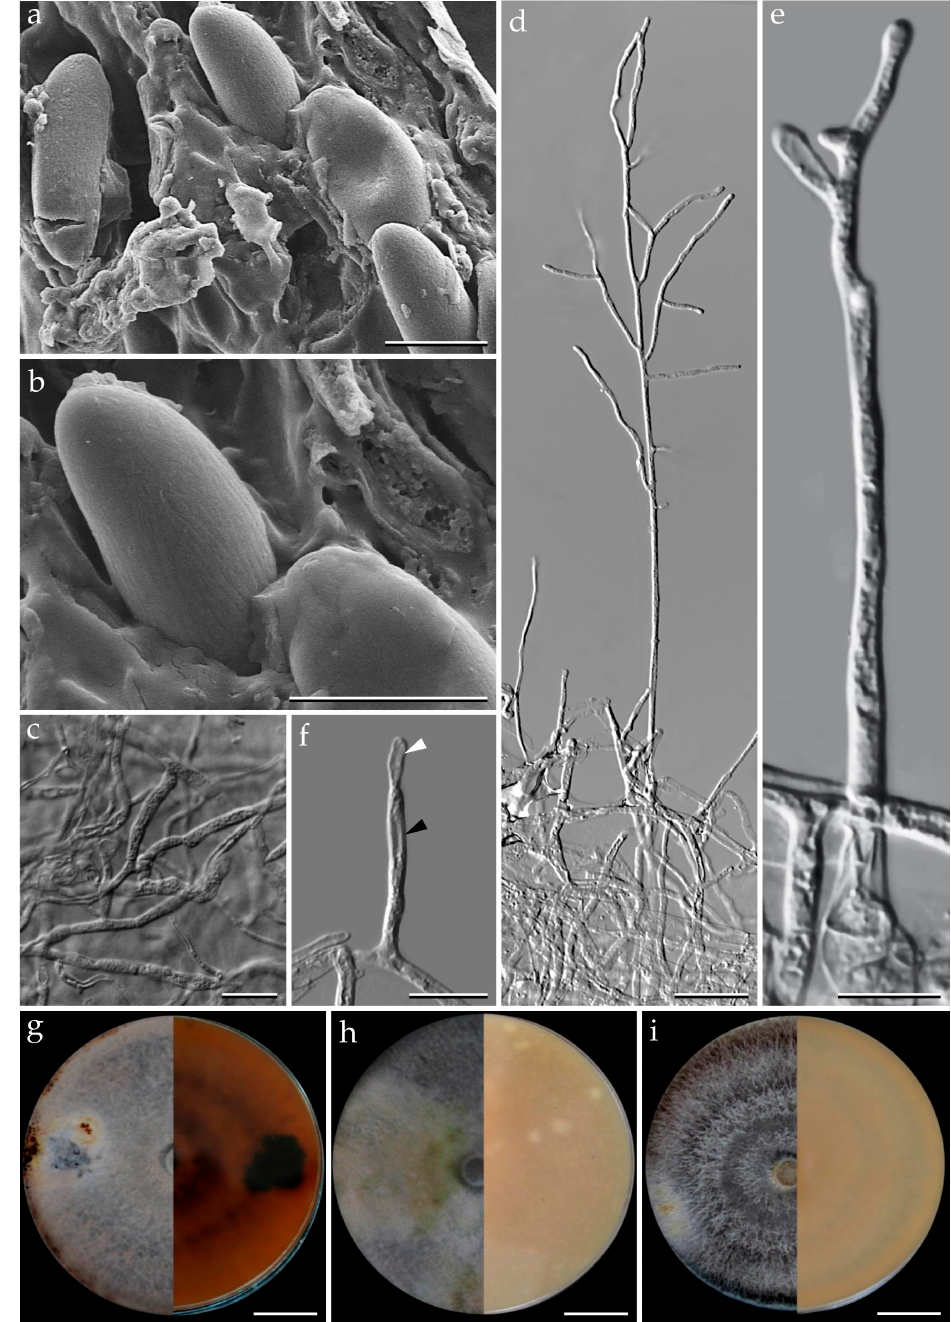
Figure 5. Pyrenopolyporus bambusicola strain BCC89369. ( a , b ) Ascospores by SEM; ( c ) vegetative mycelium; ( d , e ) aerial mycelium showing branching pattern; ( f ) conidia (white arrow) and conidiogenous cell (black arrow); ( g ) colony on PDA after one month; ( h ) colony on OA after one month; ( i ) colony on YMGA after one month. Scale bars: ( a , b ) = 5 µm; ( c , e , f ) = 10 µm; ( d ) = 20 µm; ( g – i ) = 2 cm. Additional specimens examined. Thailand: Tak Province, Pa Daeng Mine’s area, 16°41 ′ 46 ″ N, 98°36 ′ 56 ″ E, reforestation forest, on bamboo trunk (Bambusoideae) in fi re damaged area, 4 September 2018, P.S. and S.W., (BCC89369, BBH47923; BCC89360). Secondary metabolites . Stromata contain hypoxylone ( 1 ), BNT ( 2 ), and an unknown hydroxy derivative of hypoyxlone ( 3 : [M + H] + = 349.07041 Da; C 20 H 12 O 6 ; Figure S8) as major constituents (Figures 18 and S7 and Table